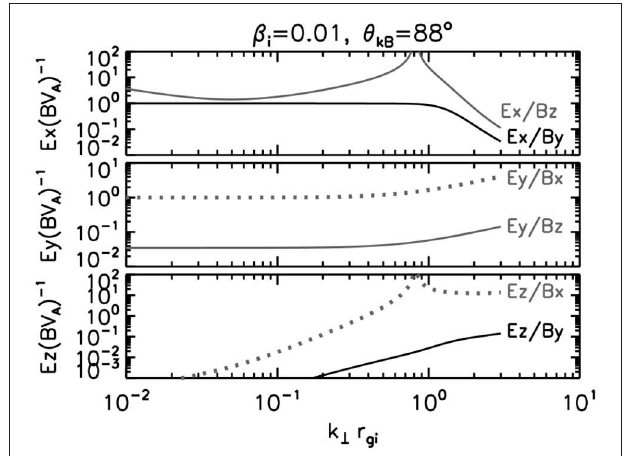
FIGURE 5 | Ratios of the electric field to the fluctuating magnetic field for various